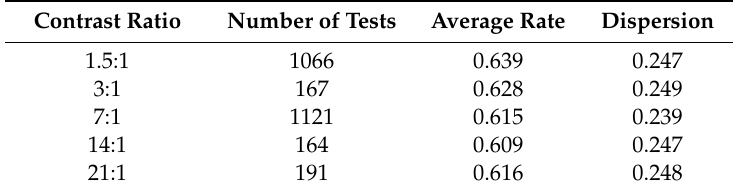
Table A5. Numerical results of the users regarding the contrast ratio.